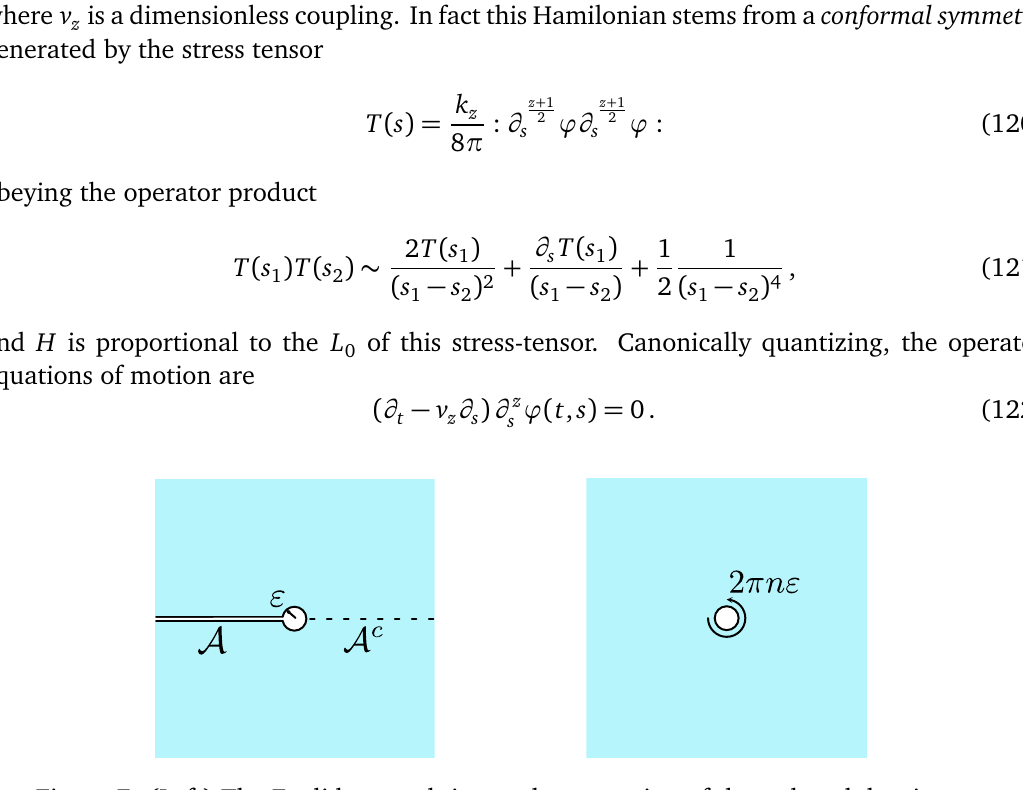
Figure 7: (Left) The Euclidean path-integral preparation of the reduced density ma- trix on A is regulated by cutting a (cid:34) keyhole around the entangling surface (which runs out of the page). (Right) The n th Rényi entropy is computed by path-integral with a cylinder of circumference 2 π n (cid:34) excised around the entangling surface. For the q -tensor Chern-Simons theory the action entirely pulls back to this